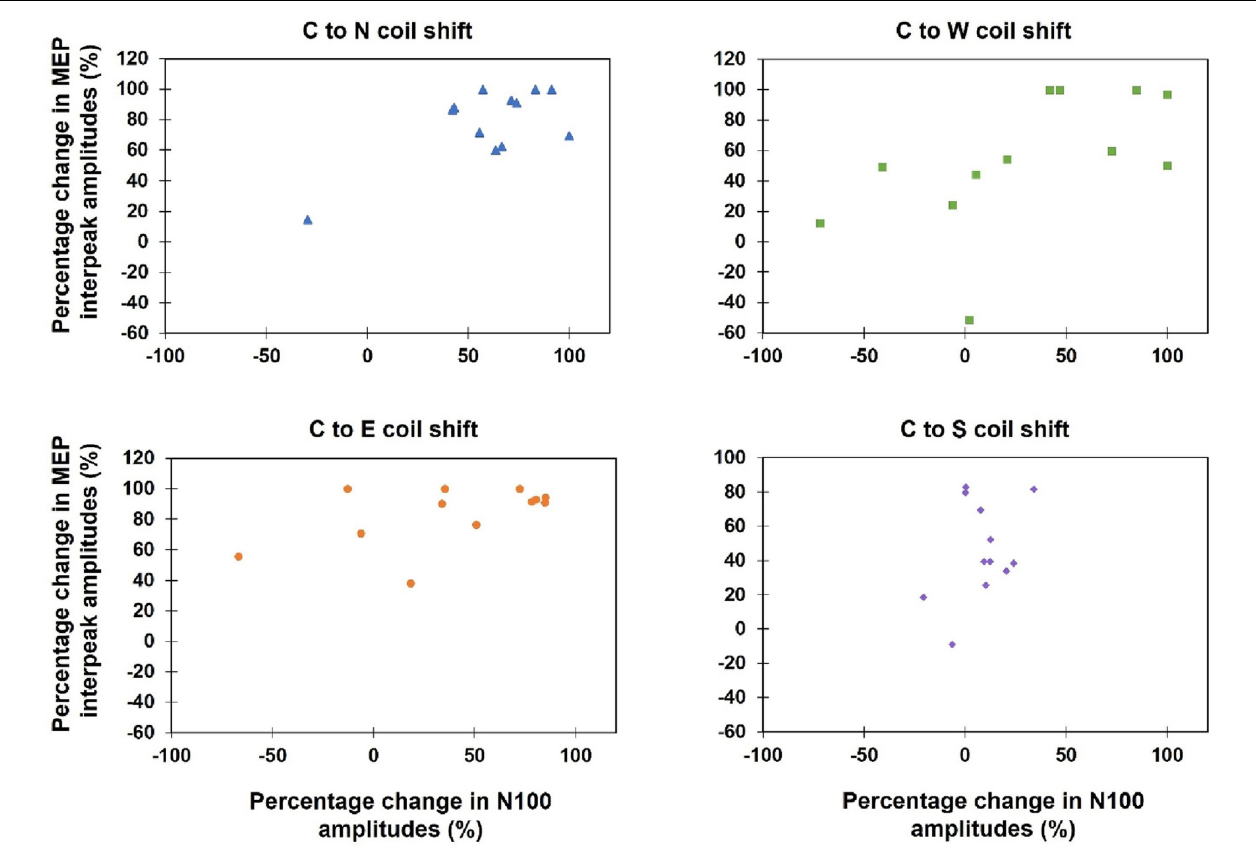
FIGURE 7 | Scatterplots of the percentage change of the MEP interpeak amplitudes and N100 amplitudes, when the coil was moved away from the hot spot condition (Central) to one of the four main directions (North, East, South, West).